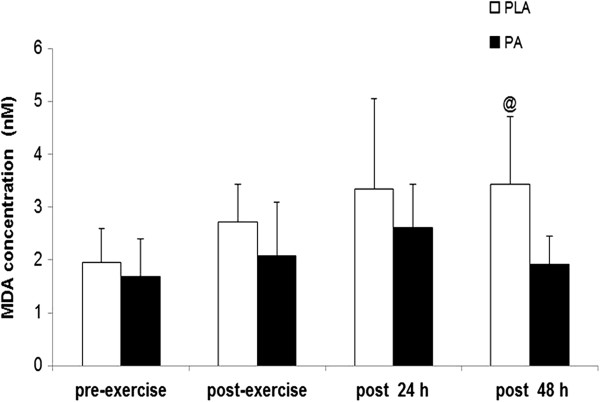
MDA concentration before exercise (pre-exercise), immediately after (post-exercise), and 24 h (post 24 h) and 48 h (post 48 h) after high-intensity exercise. Values are presented as mean ± SE (n = 12). MDA, malondialdehyde; PLA, placebo @Significantly different from the PLA group at the same time point (p < 0.01).